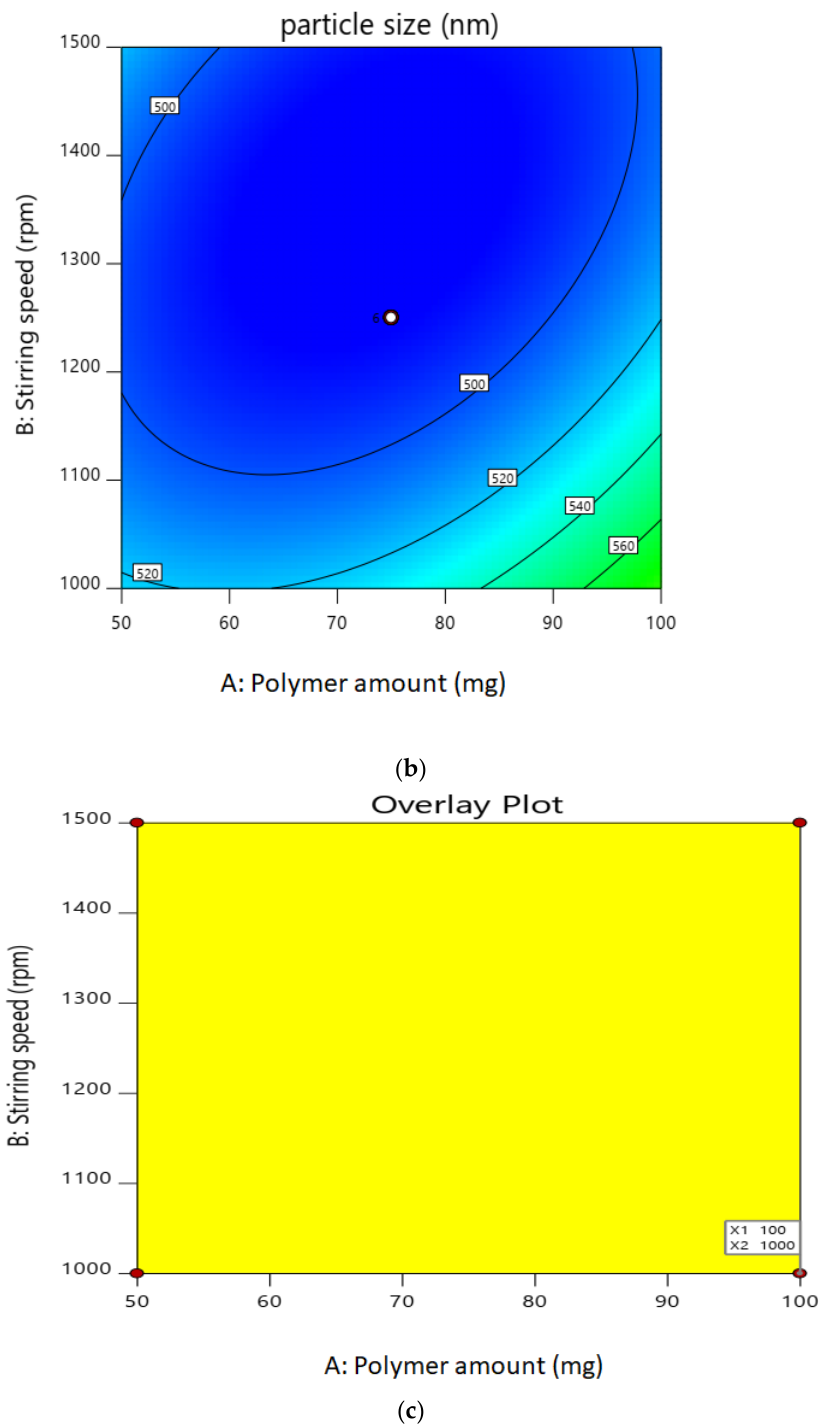
Figure 1. ( a ). Contour plot of drug entrapment. ( b ). Contour plot of particle size. ( c ). Overlay plot for confirmation.